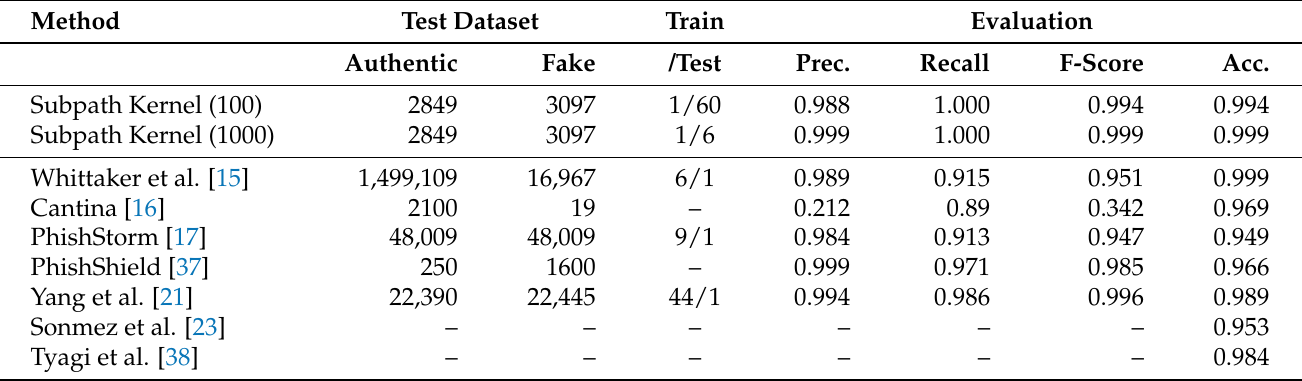
Table 2. Comparison in accuracy performance of our method (Subpath Kernel) against benchmark methods: P REC . = TP R ECALL = TP ; F-S CORE = 2 × TP ; A CC . TP + FN 2 × TP + FP + FN